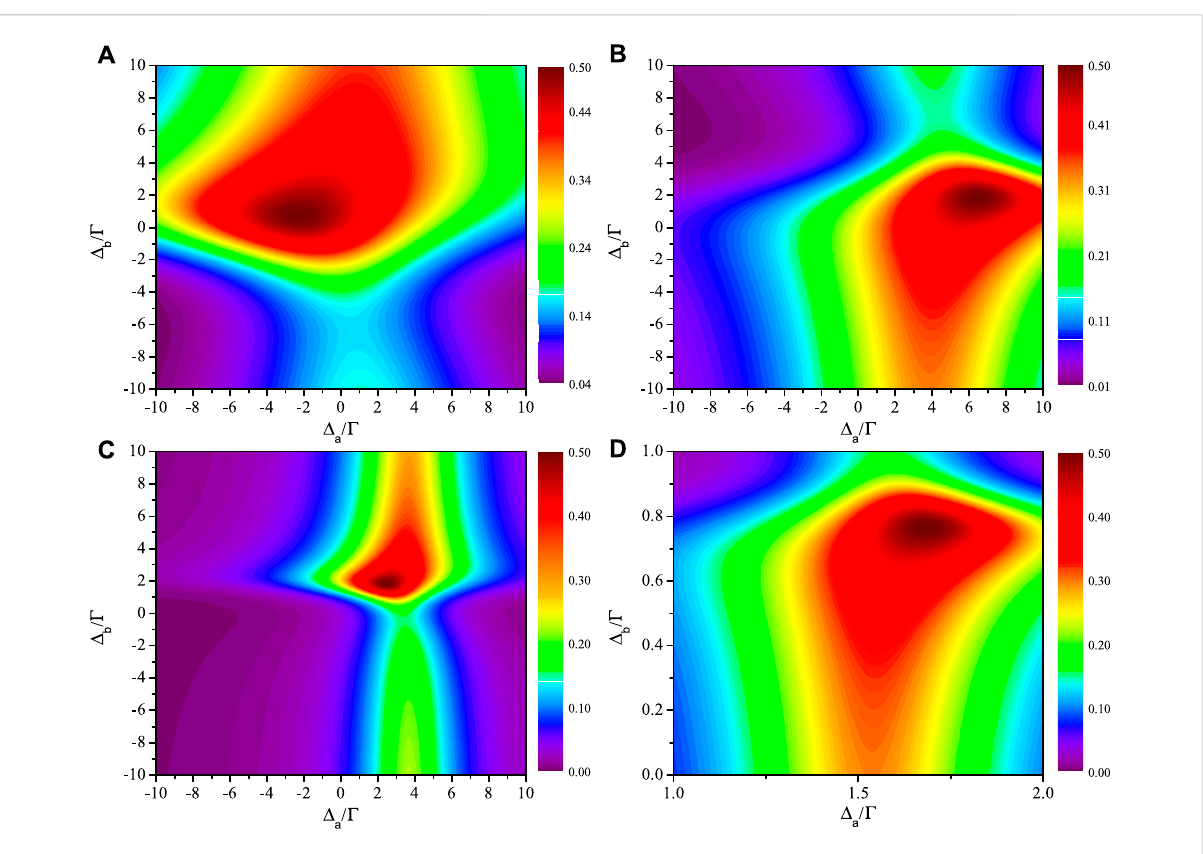
FIGURE 7 Transmissionrate T n asafunctionof Δ a and Δ b ,inwhichthefourvaluesofthephaseshift θ aregivenbyTable2.Specially, (A) θ = π /8, (B) θ =3 π /8, (C) θ = 5 π /8, (D) θ = 7 π /8. The transmitted spectra with the other four values of θ are not presented here. The total transfer ef fi ciency from the waveguide m to n can achieve 100% by adjusting the detunings. The other parameters are Γ a = Γ b = Γ , g =